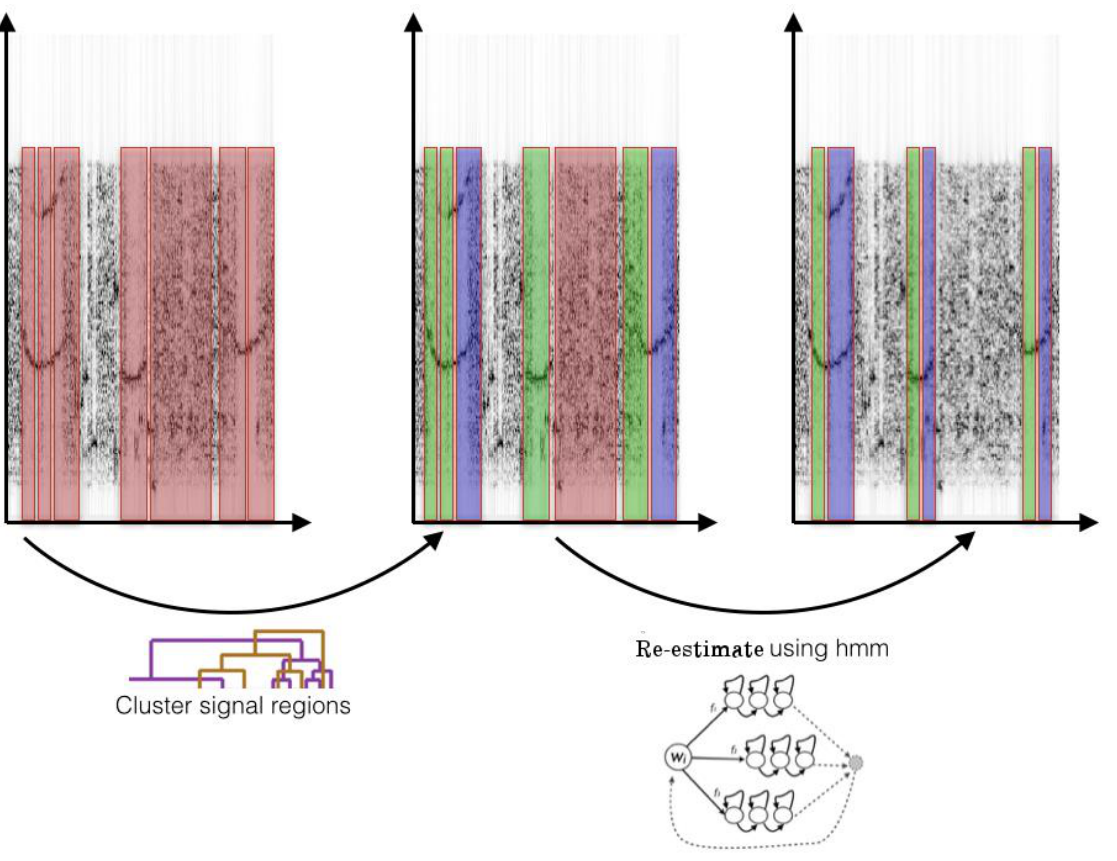
Figure 14. Overview of the data mining system. After identifying signal and noise regions using a binary classifier, the resulting regions are clustered. For the final estimate we train a left-to-right hidden Markov model for each cluster. Together the models form a mixture of hidden Markov models. Decoding each sequence with that mixture gives a smooth segmentation, fixing boundary errors and noise